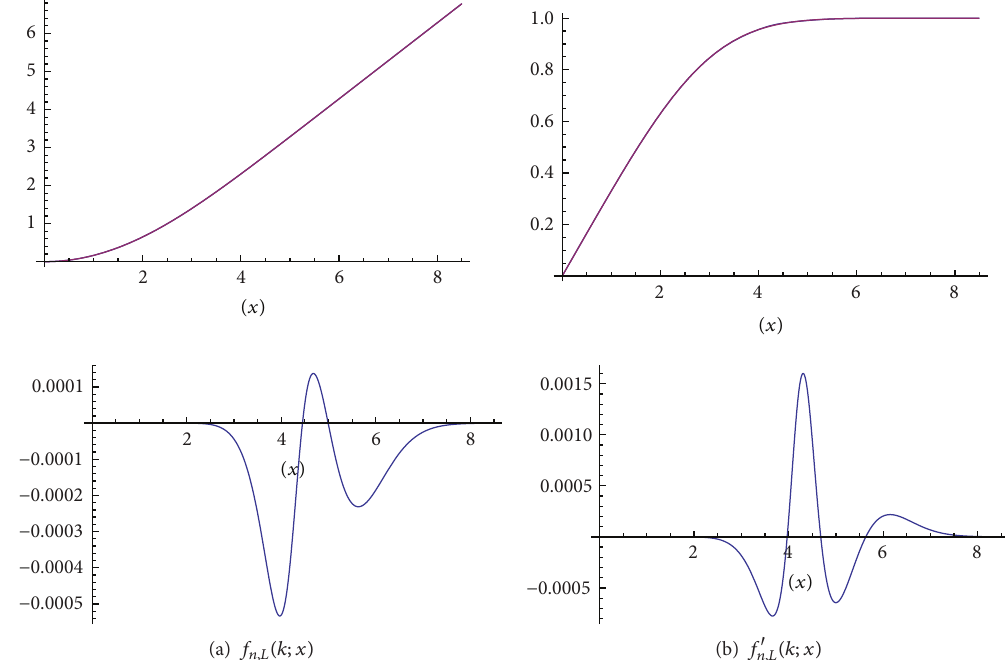
Figure 4: Approximation of the weighted average 𝑓 𝑛,𝐿 (𝑘; 𝑥) with the parameters (𝑛,𝐿, 𝑘) = (4,8.5, 11) and its error in (a) and those of the related velocity profile 𝑓 󸀠 𝑛,𝐿 (𝑘;𝑥) in (b).